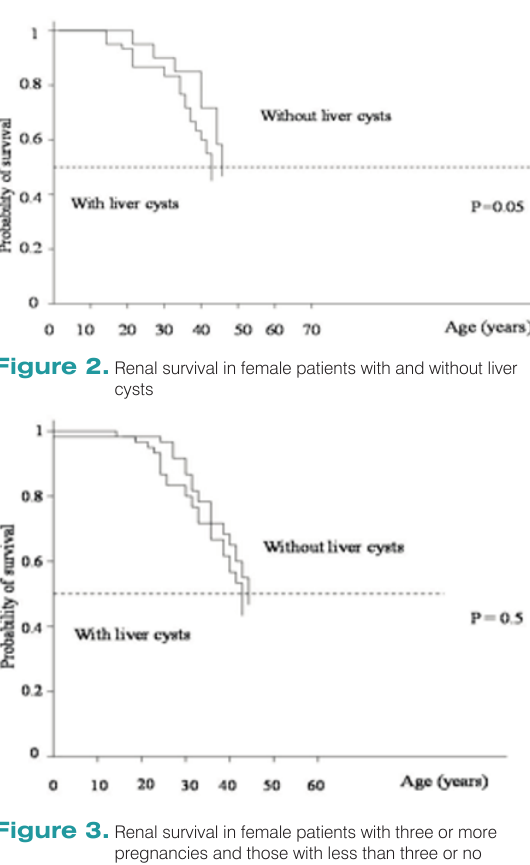
Figure 1. Renal survival in patients with and without liver cysts